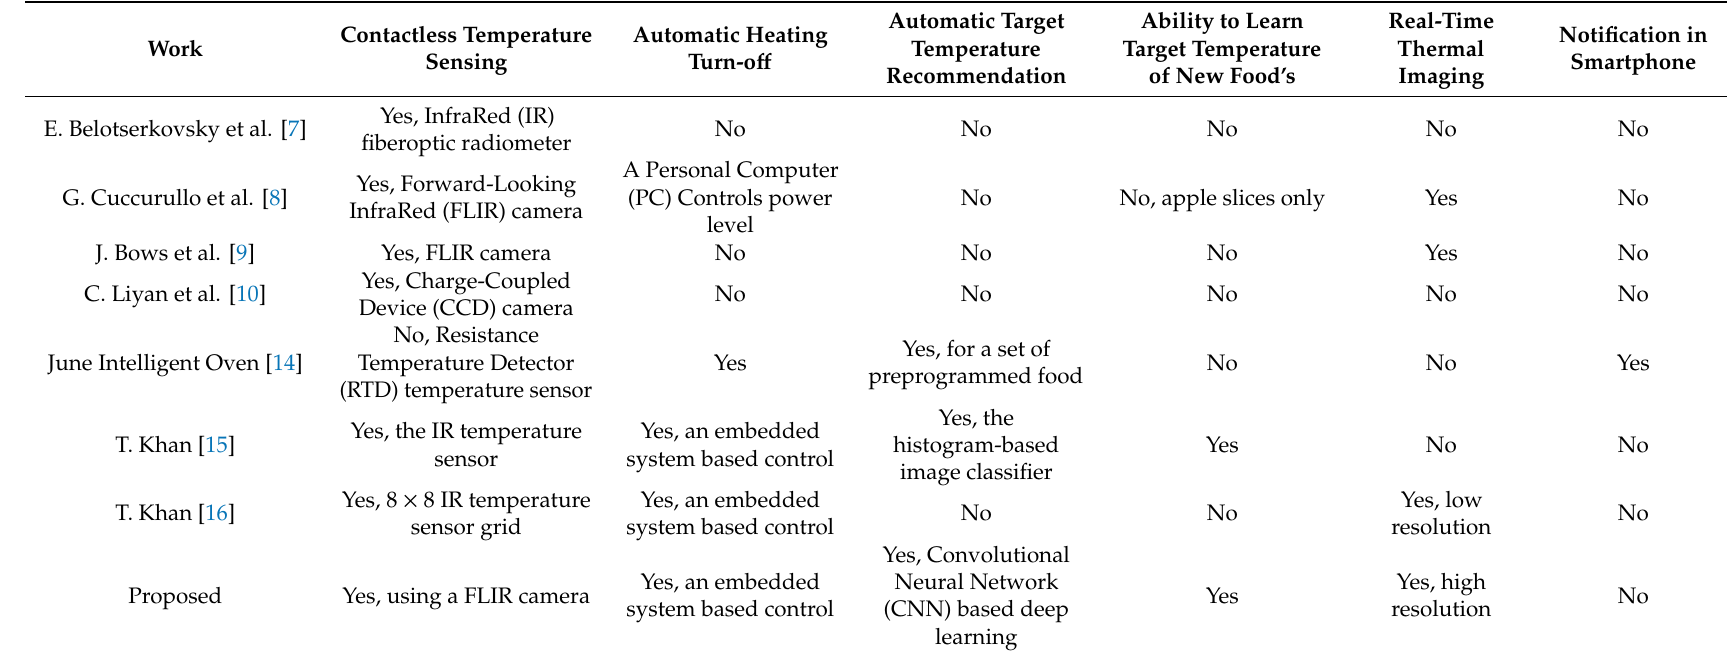
Table 1. Comparison with other